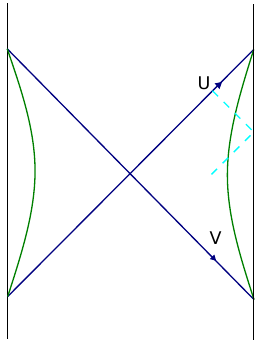
Figure 2 . The portion of the cutoff boundary between the two dashed curves is connected to the point on the horizon by a